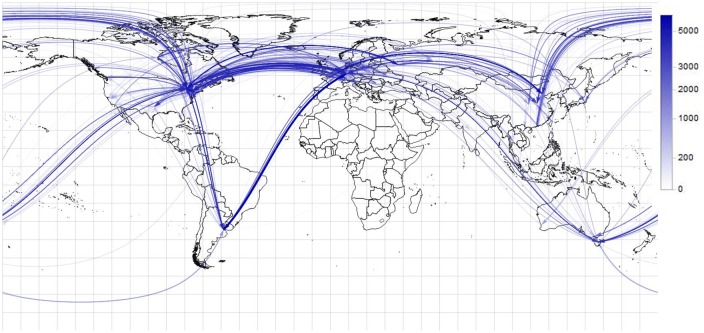
The flow of Bitcoin.